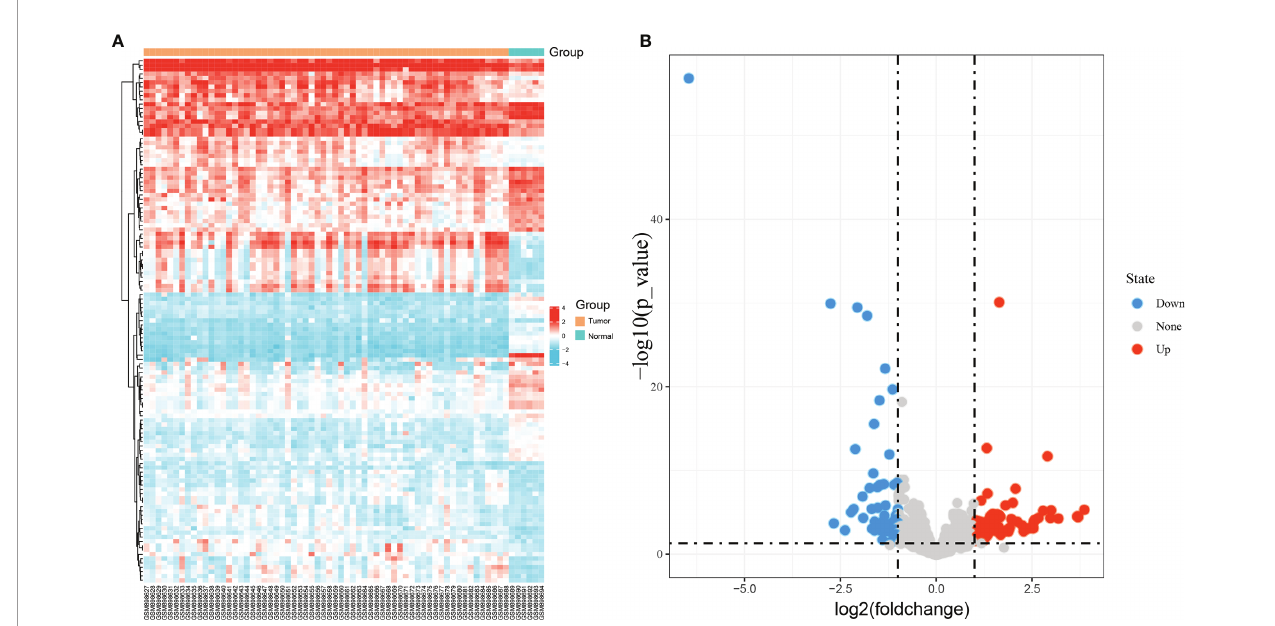
FIGURE 1 | Identi fi cation of differentially expressed miRNAs in GSE36682. (A) heat map showing differentially expressed miRNAs; (B) volcano map showing differentially expressed